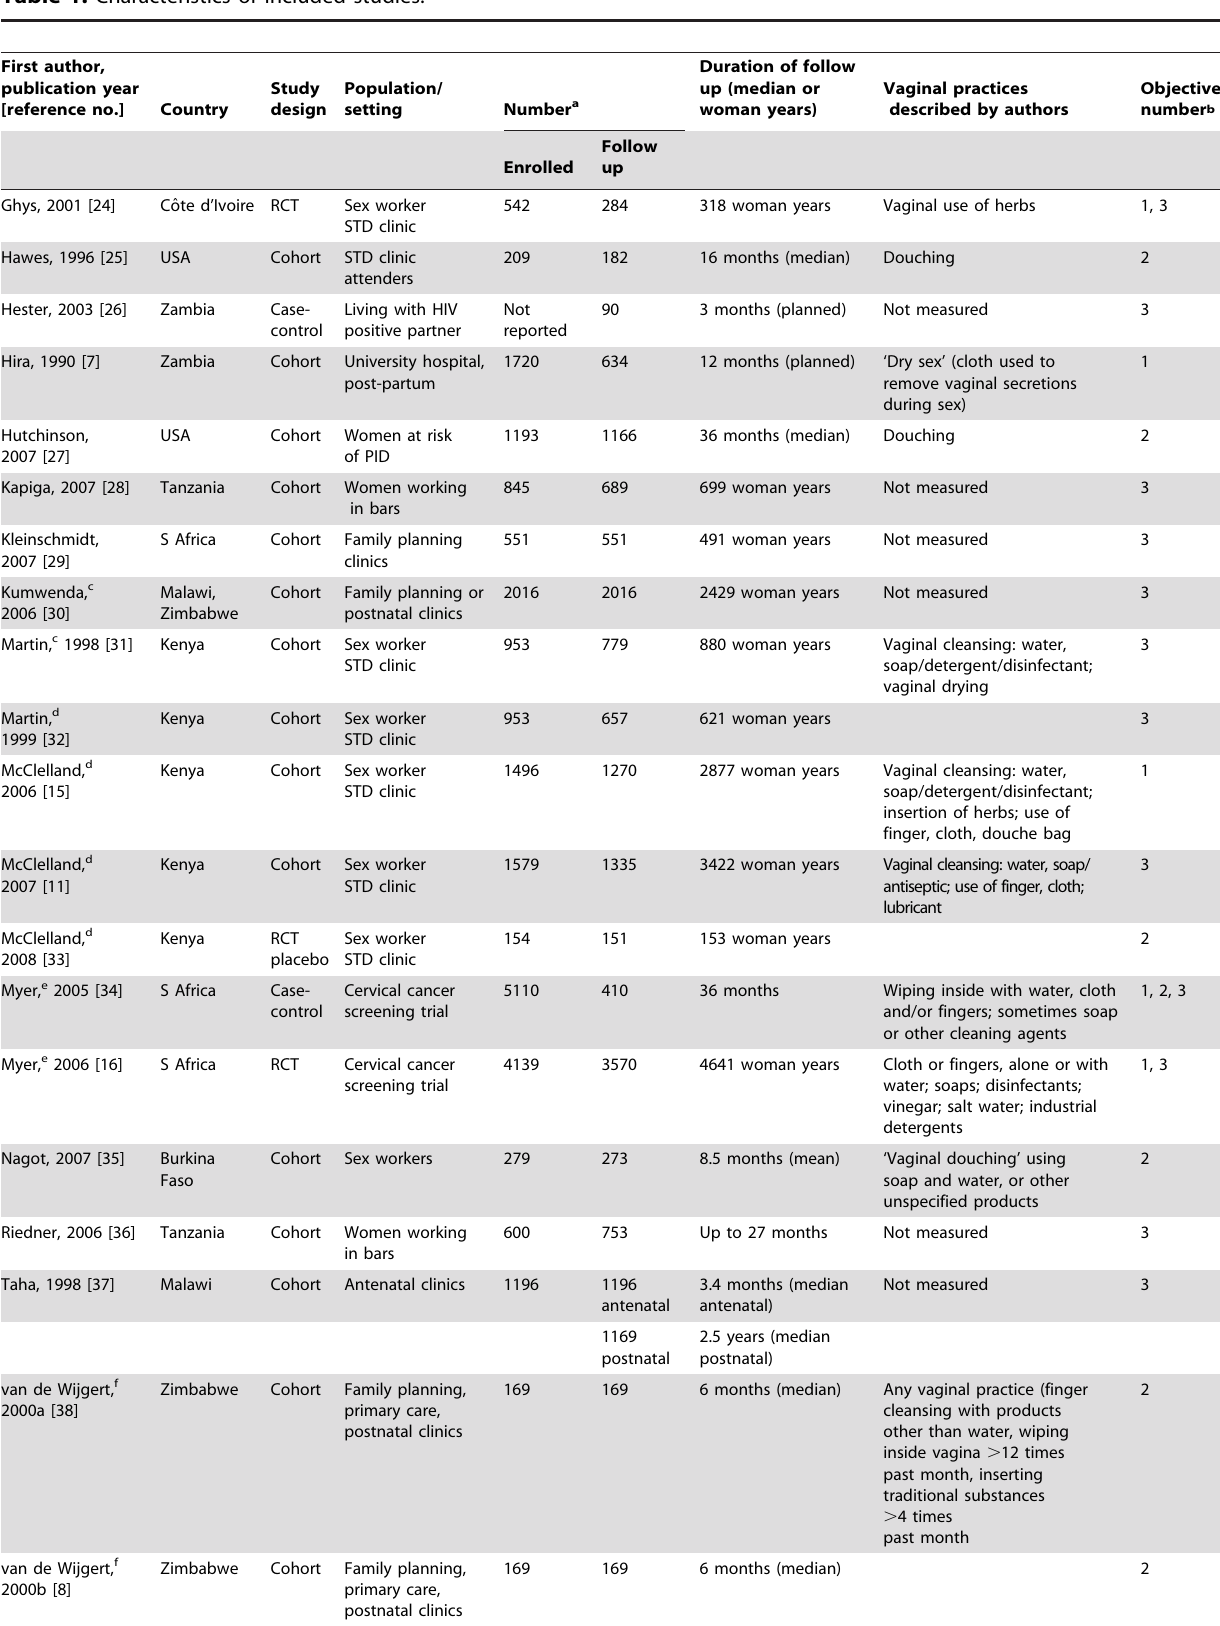
Table 1. Characteristics of included